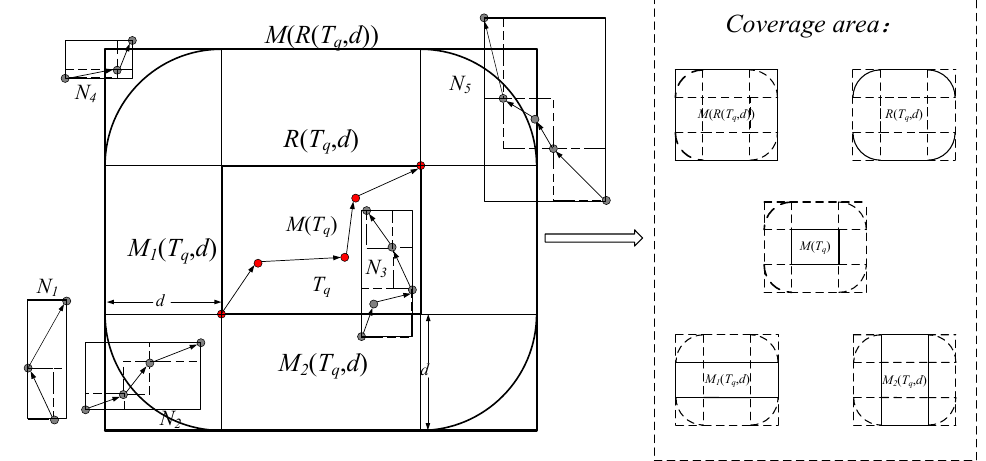
Figure 4. Example of extended MBR overlap based pruning strategy.